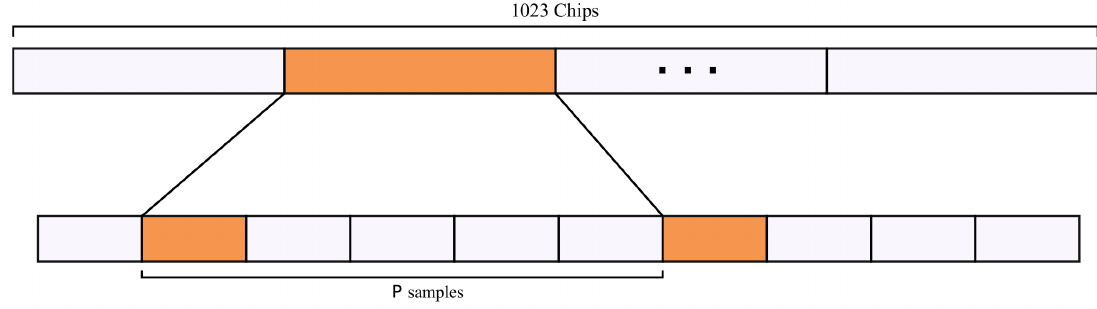
Figure 3. An illustration of chip